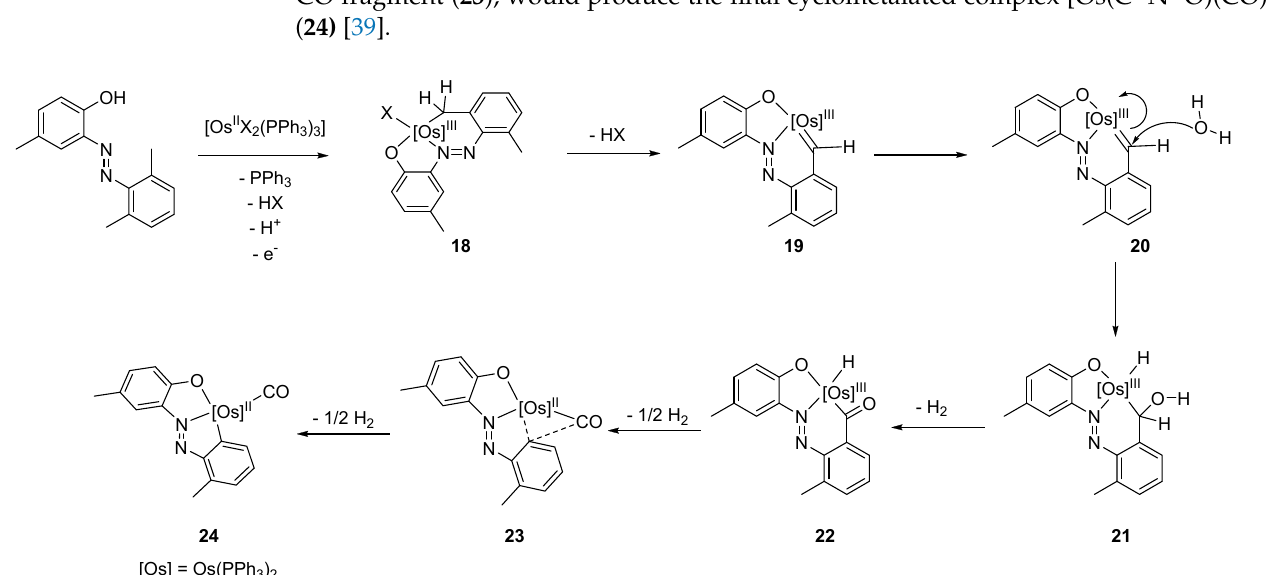
Figure 4. Cyclometalated complexes derived from 2-vinylpyridine.